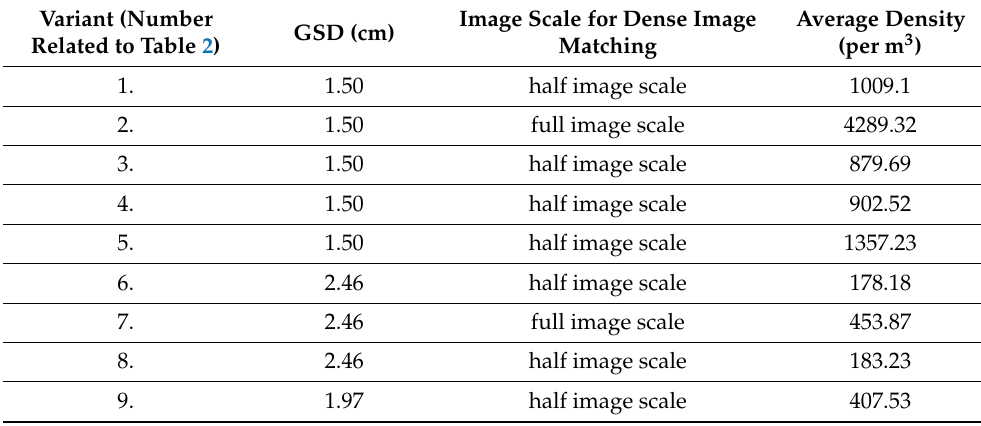
Table 6. Comparison of point cloud densities per m 3